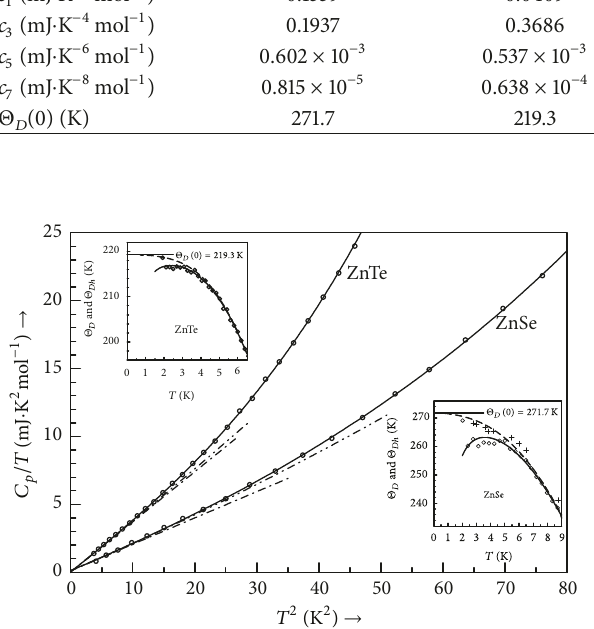
Figure 6: Fittings via (35) of the 𝐶 𝑝 (𝑇)/𝑇 data points ( I ) corre- sponding to the cryogenic 𝐶 𝑝 (𝑇) data provided by Kremer et al. [46] for ZnSe and ZnTe [—, least-mean square fittings from 2K to 8.7 K or to 6.4 K, resp.; ⋅⋅ – ⋅⋅ – ⋅⋅ – ⋅⋅ , tail behaviour, for 𝑐 7 → 0; ⋅ – ⋅ – ⋅ – ⋅ , 𝑇 → 0 asymptote,for 𝑐 7 = 0 and 𝑐 5 = 0 ].Theinsetsshowtheeffective Θ 𝐷 (𝑇) values ( I ) following directly (via (25)) from Kremer’s cryogenic 𝐶 (𝑇) data [46] for ZnSe and ZnTe. For comparison we have still 𝑝 included the Θ 𝐷 (𝑇) values (+) following from former 𝐶 𝑝 (𝑇) data quoted for ZnSe by Birch [34], which show no indication for an appreciable electronic contribution. The continuous curves in the insets are resulting from (25), implying the cryogenic 𝐶 𝑝 (𝑇) series expansion (see (33)), with fitted Taylor series expansion coefficients listed in Table 3. [ —, Θ 𝐷 (𝑇) curve, for 𝑐 1 > 0; –––––, Θ 𝐷ℎ (𝑇) curve, for 𝑐 1 → 0. ]